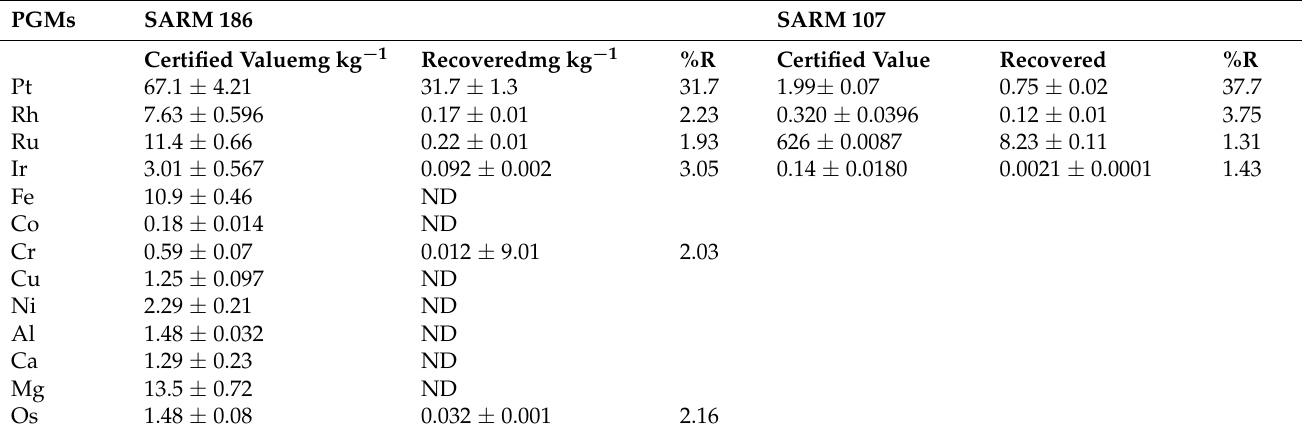
Table 6. Effect of other PGMs present in ore samples on the extraction and recovery of Au(III) and